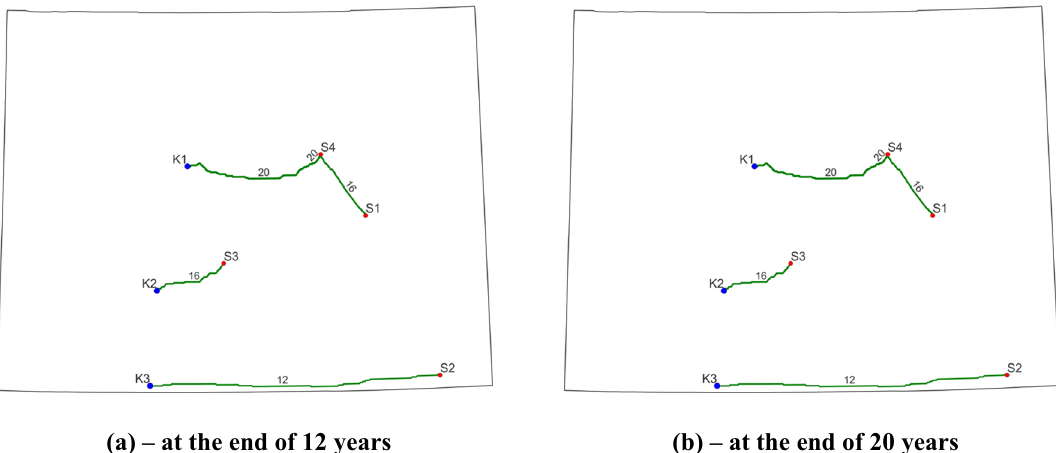
Figure 4. Final optimized CO 2 pipeline network for Cases 1–3. Blue dots represent sinks, red dots represent CO 2 point sources, and green curves indicate the optimized pipeline routes (the number and thickness denote the pipeline diameter).